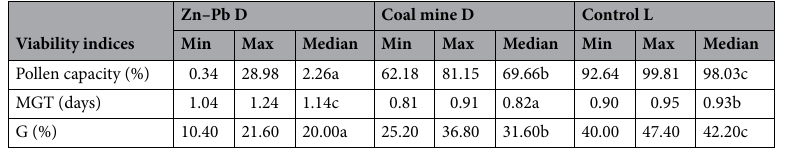
Table 3. Results of the non-parametric multi-comparison test of B. pendula viability indices (pollen capacity and mean germination time (MGT), germination percentage (G) of seeds from Zn–Pb D, Coal mine D and Control L sites (the significance level α = 0.05; a different letter means significant